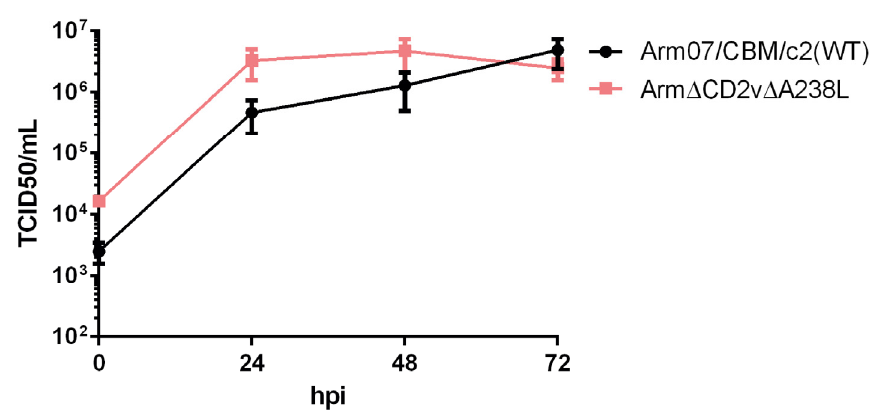
Figure 2. Arm/07/CBM/c2 and Arm- ∆ CD2v- ∆ A238L in vitro growth in PAM. PAM were infected with either Arm/07/CBM/c2 WT or Arm- ∆ CD2v- ∆ A238L at MOI = 0.5. At the indicated times post infection, total virus was recovered and titrated by TCID50 assay in COS-1 cells.